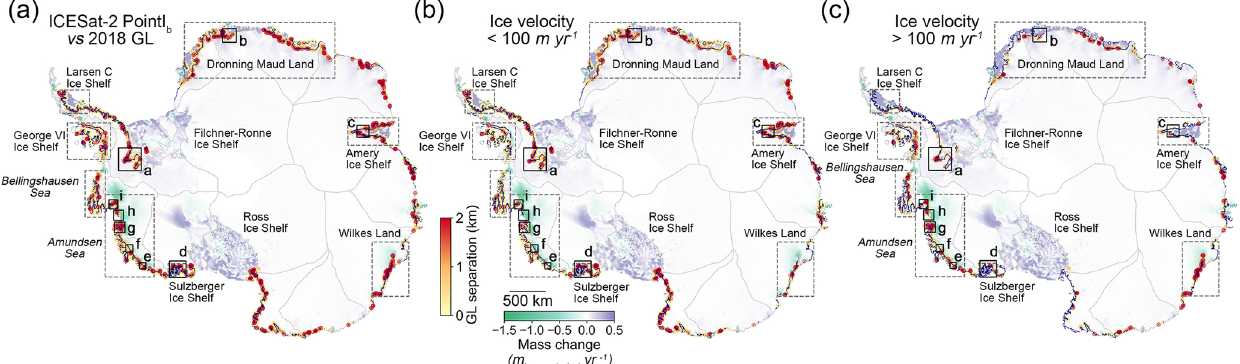
Figure 11. (a) Absolute separations between the ICESat-2-derived break in slope (Point I b ) and 2018 DInSAR-derived Point F (Mohajerani et al., 2021). (b) Regions with ice velocity (Rignot et al., 2017) less than 100myr − 1 , (c) regions with ice velocity larger than 100myr − 1 . The black boxes denote the spatial extents of regions mapped in Fig. 12. In all subplots, data are superimposed over the recent mass change map (Smith et al., 2020b) and IMBIE basin boundary (Shepherd et al., 2018; Rignot et al., 2011b).